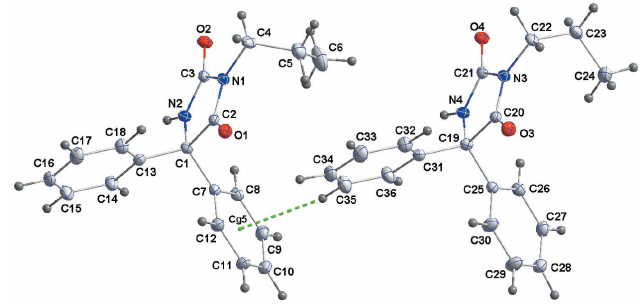
Figure 1 The asymmetric unit with labeling scheme and 50% probability ellipsoids.